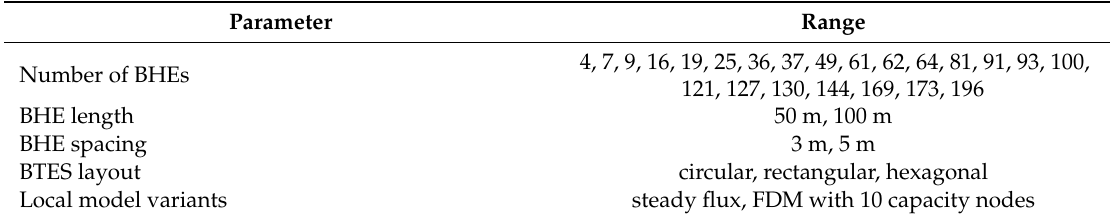
Table 1. Parameter range for the 3D finite element method (FEM) benchmark models.